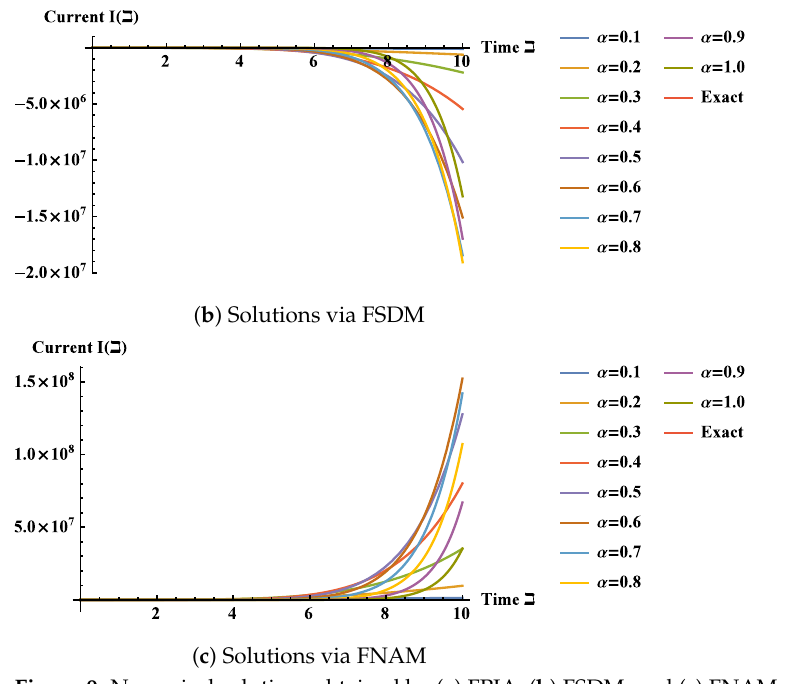
Figure 9. Numerical solutions obtained by ( a ) FPIA, ( b ) FSDM, and ( c ) FNAM of the fractional-order electrical inductor–resistor circuit equation at different α